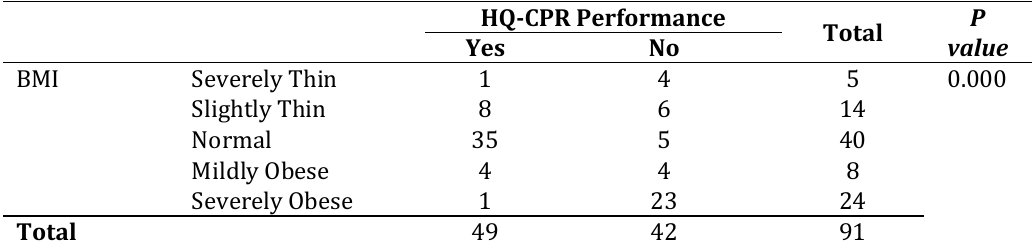
Kolmogorov Smirnov Non-Parametric Test